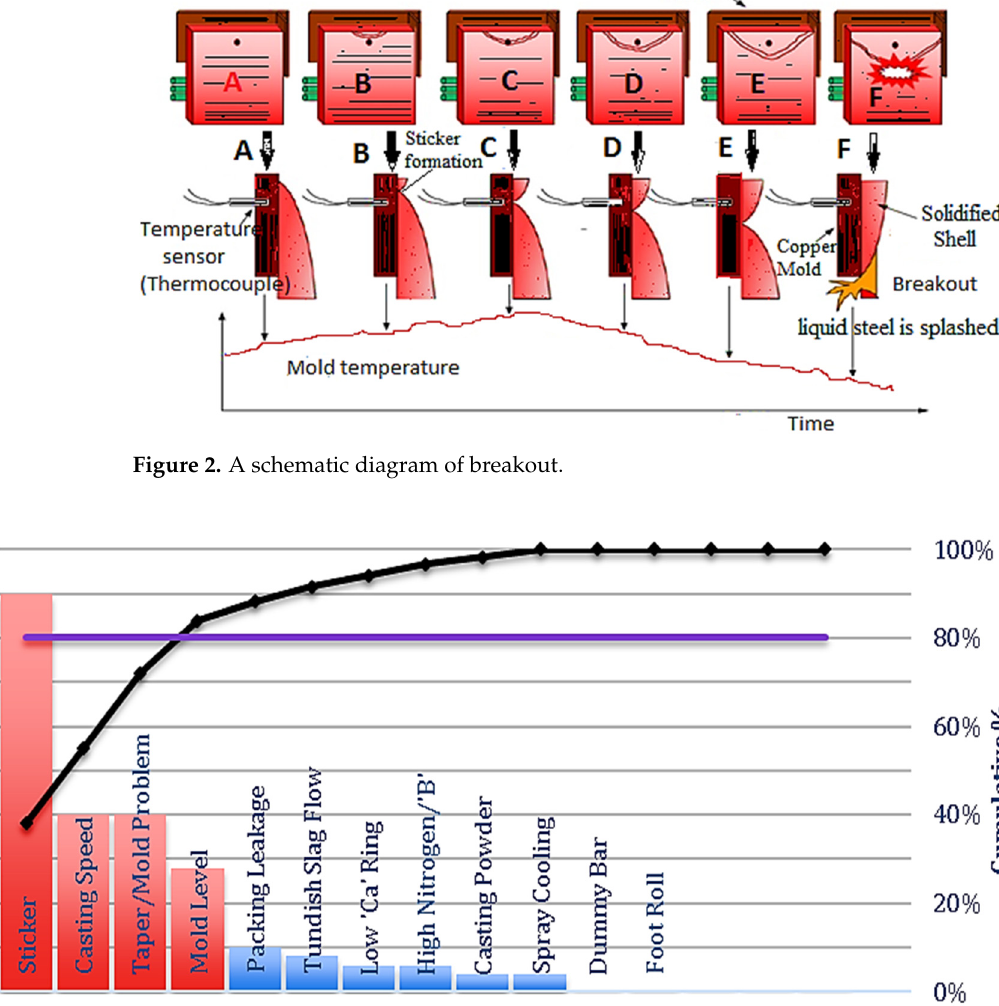
Figure 3. Pareto chart of causes of breakout.